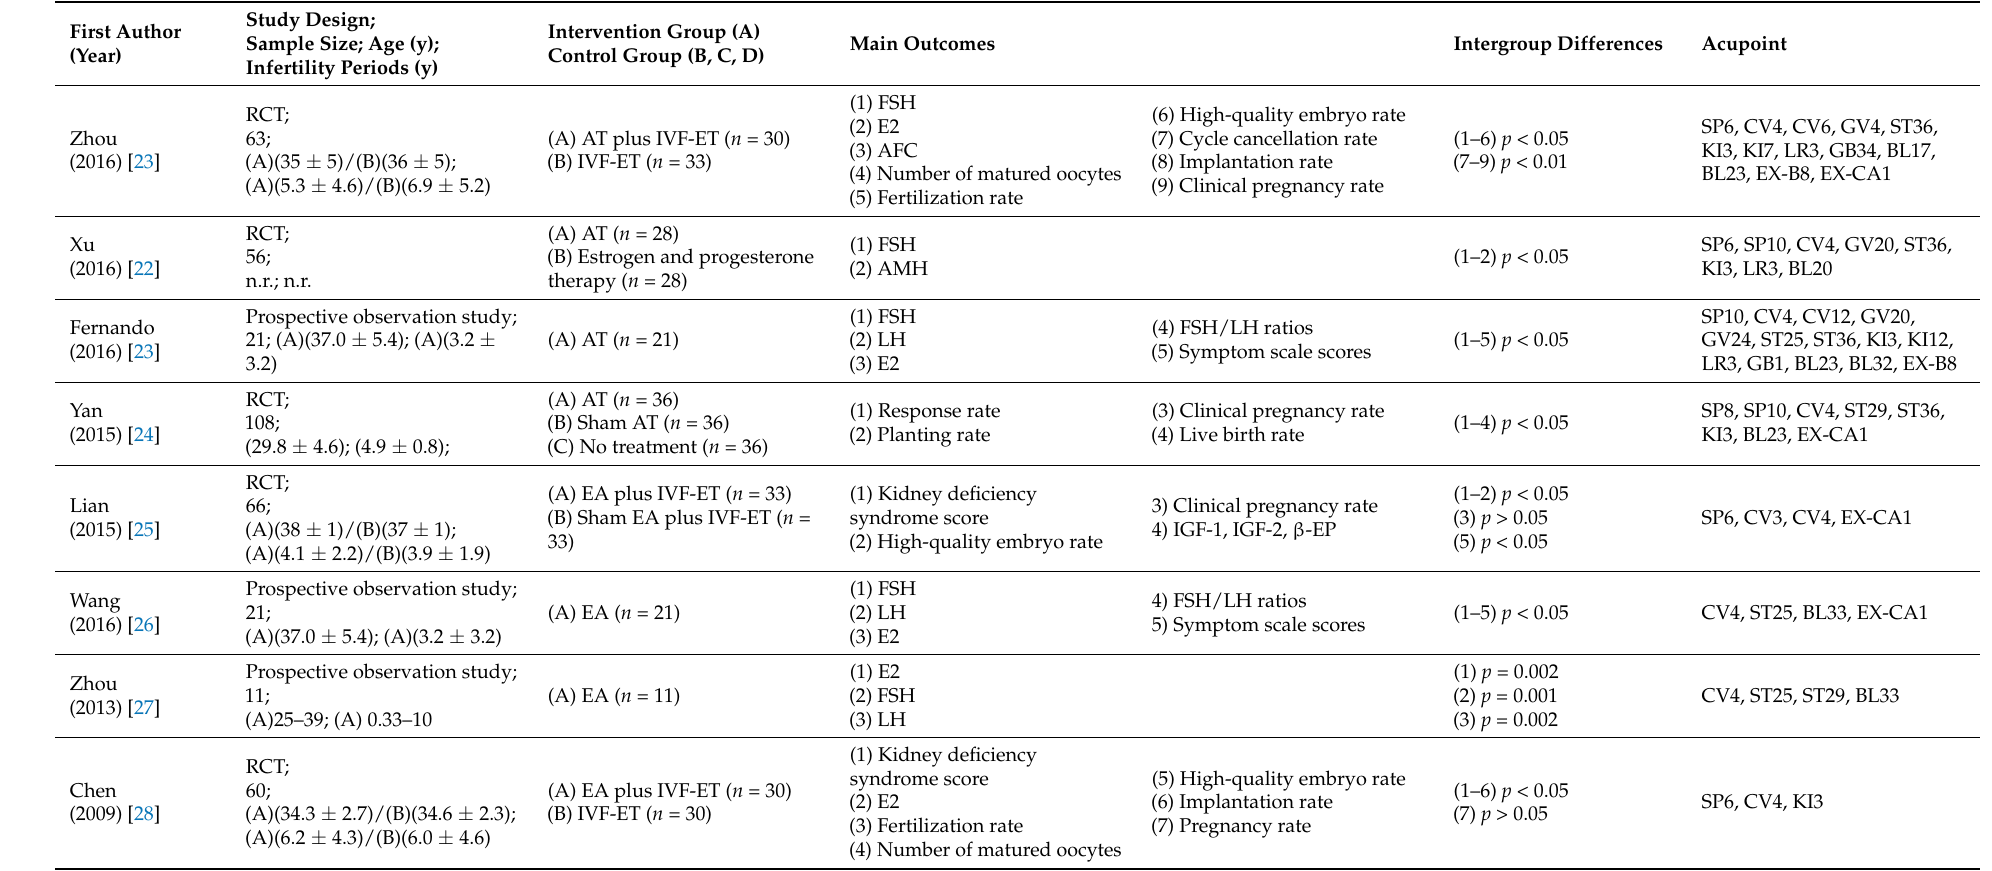
Table 1. Summary of data from the systematic